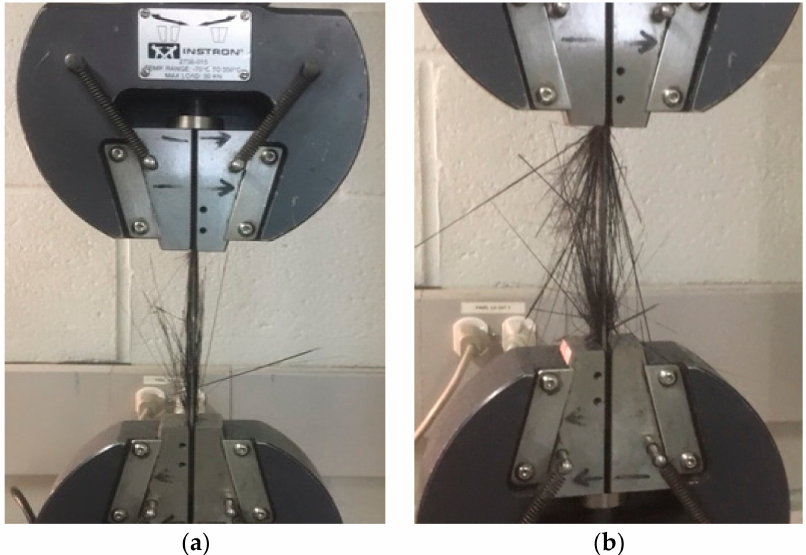
Figure 7. Fracture profile of tensile tested carbon flax hybrid composites ( a ): initiation of fibre rupture and ( b ) outer plies carbon fibre